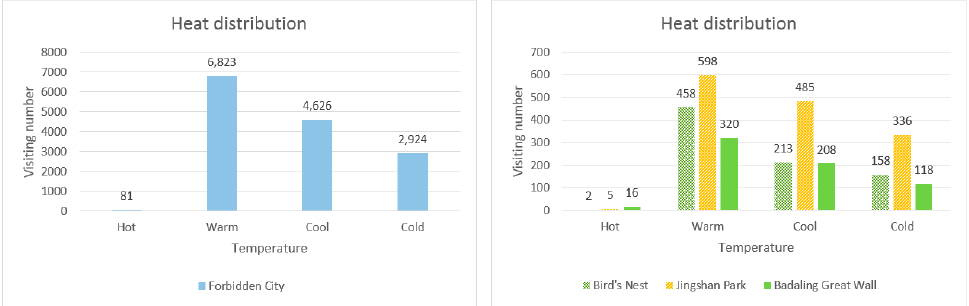
Figure 18. Heat distribution map divided by temperature.